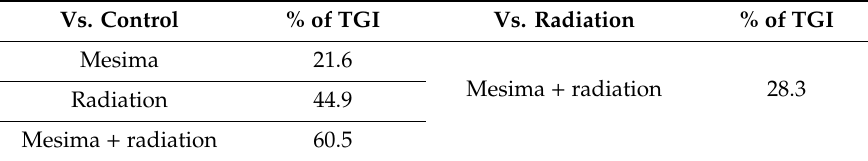
Table 5. Tumor growth inhibition (TGI) compared to control group or radiation group in the presence or absence of mesima. Values were obtained from Figure